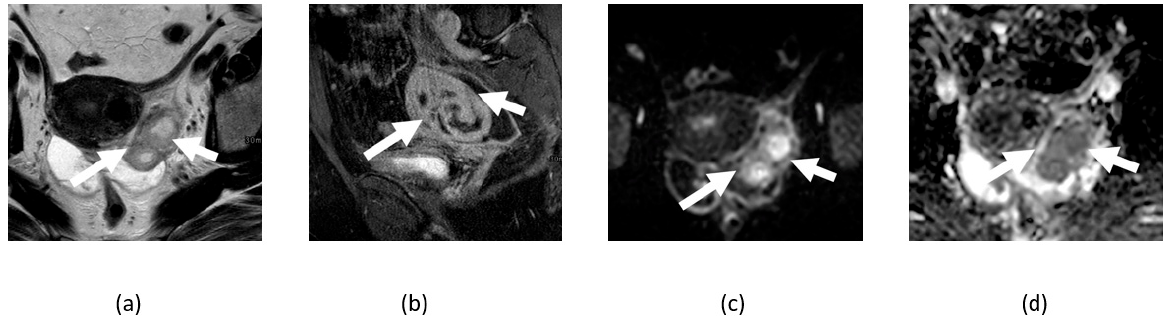
Figure 8. Axial T2-weighted ( a ), sagittal T1-weighted fat saturation post-contrast ( b ), DWI ( c ) and ADP maps ( d ) show serpiginous thick enhancing walled left adnexal pyosalpinx with restricted diffusion (arrows).